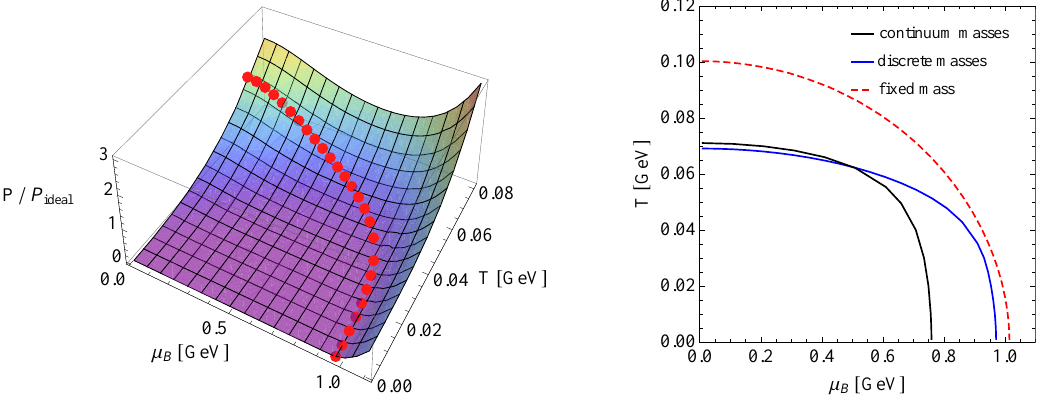
Figure 10. Left panel: Pressure (normalized to the ideal gas limit) as a function of temperature and baryonic chemical potential in the case of a non-extensive gas with particles with discrete masses. Red dots indicate the region where the gas total energy inside a volume V proton is equal the proton mass, i.e., ε · V proton = m proton . Right panel: Temperature as a function of baryonic chemical potential T = T ( µ B ) for a non-extensive gas within the constraint ε · V proton = m proton . For comparison, the results are displayed in three different scenarios: (i) continuum masses, (ii) discrete masses, and (iii) fixed mass. It is considered the value q = 1.14 in both panels. Left panel taken from ref.